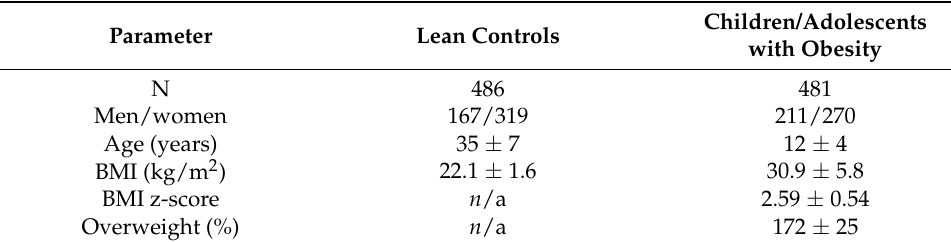
Table 2. Population characteristics. Mean values ± standard deviation are shown. BMI z-score is based on the Flemish Growth Charts [27]. Overweight (%) is calculated as follows: BMI/P50 BMI for age and sex × 100. n /a not applicable.